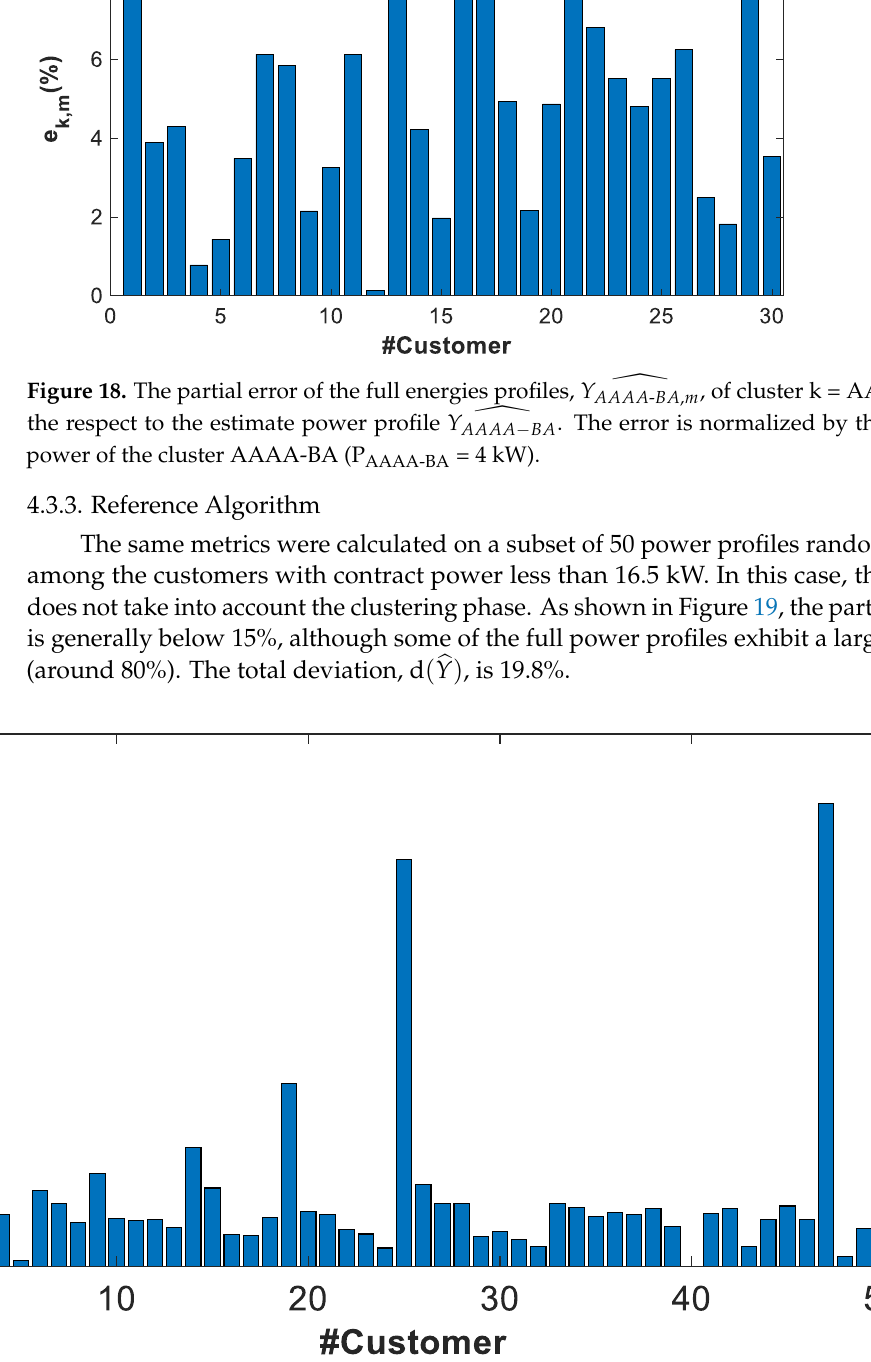
Figure 17. The partial deviation of the full energies profiles, 𝑌 𝐴𝐴𝐴𝐴−𝐵𝐴,𝑚 ̂ , of cluster k = AAAA-BA with the respect to the estimate power profile 𝑌 𝐴𝐴𝐴𝐴−𝐵𝐴 ̂ . The deviation is normalized by the con- tractual power of the cluster AAAA-BA (P AAAA-BA = 4 kW).